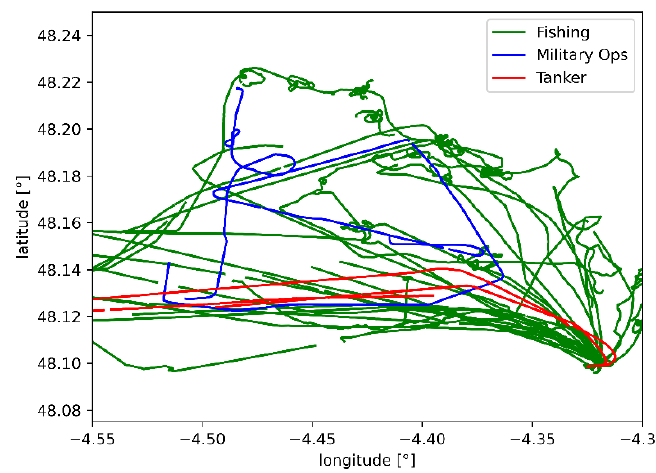
Figure 8. Visualization of local recognition results.